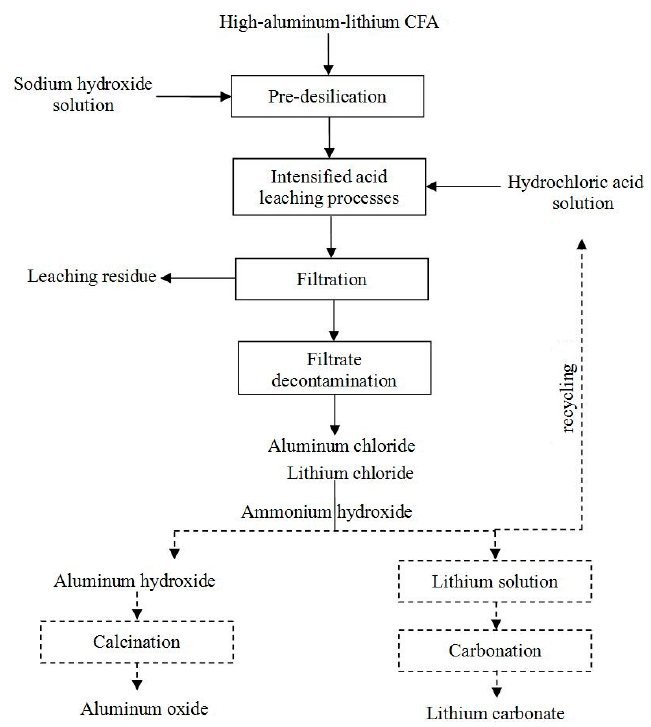
Figure 3. A flow diagram of the extraction of aluminum and lithium from coal fly ash (CFA).